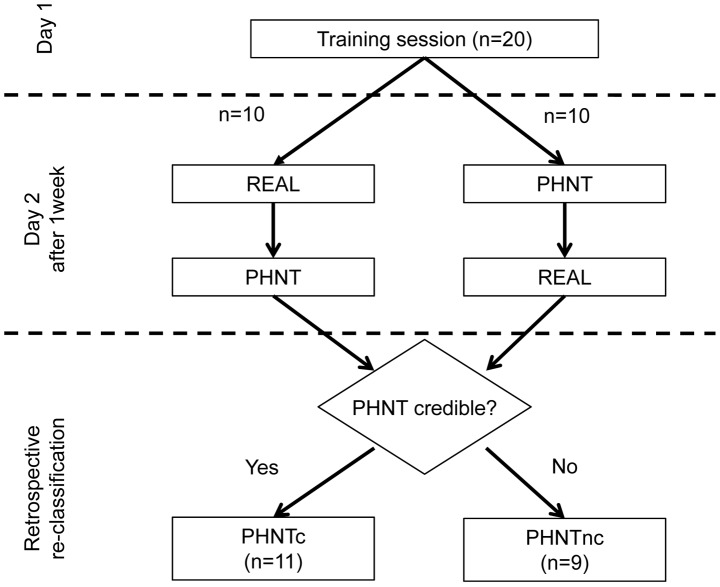
Study flow.Among twenty healthy subjects, ten received real acupuncture (REAL) first, while the rest received phantom acupuncture (PHNT) first, and they were re-classified into phantom credible (PHNTc) and phantom non-credible (PHNTnc) according to the needling credibility in phantom acupuncture (PHNT).